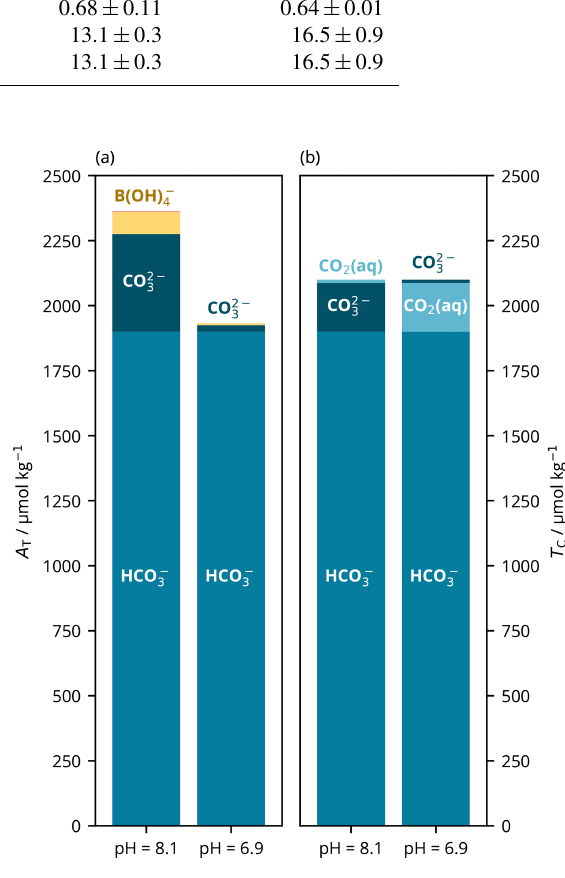
Figure 7. Main components of (a) total alkalinity ( A T ) and (b) dis- Figure 8. Main components of (a) total alkalinity ( A T ) and (b) dis- solved inorganic carbon ( T C ) at the two possible pH roots for solved inorganic carbon ( T C ) at the two possible pH roots for ] a known parameter pair of T C (2100µmolkg − 1 ) and bicarbon- a known parameter pair of A T (2300µmolkg − 1 ) and [ CO 2 − 3 ] ; 1900µmolkg − 1 ). The high-pH root ate ion content ( [ HCO − (120µmolkg − 1 ). The low-pH root (left) represents typical seawa- 3 (left) represents typical seawater, in which most of the T C not ac- ter, with relatively high T C (2143µmolkg − 1 ) and both A T and ] is composed of [ CO 2 − ] ; A T is relatively counted for by [ HCO − T C dominated by the bicarbonate ion (HCO − ). The high-pH root 3 3 3 high (2364µmolkg − 1 ) and f CO low (331µatm). In the low-pH ] , but A T is dominated by hy- (right) has the same A T and [ CO 2 − 2 3 root (right), the non-HCO − portion of T C is instead dominated droxide (OH − ), and T C is much lower (122µmolkg − 1 ) and com- 3 by CO 2 ( aq ) ; alkalinity is lower (1932µmolkg − 1 ) and f CO high prised almost entirely of CO 2 − . These calculations were carried out 2 3 (5008µatm). These calculations were carried out at 15 ◦ C, with a at 15 ◦ C, with a practical salinity of 35 and zero nutrients. If nutri- practical salinity of 35 and zero nutrients; pH is on the total scale ents were present, then like borate (B ( OH ) − ) they would have dif- 4 (Appendix ferent contributions to A T at the different pH roots; pH is on the total scale (Appendix A).